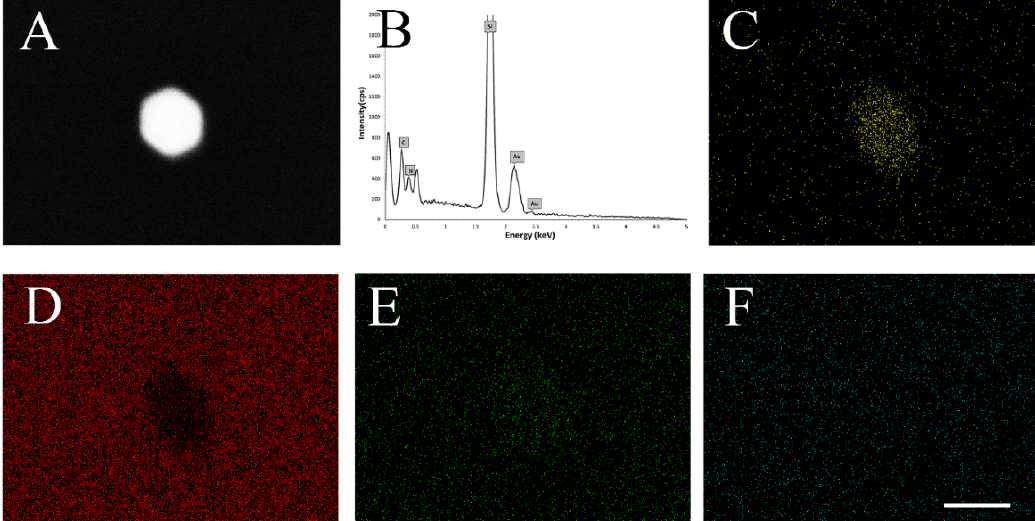
Figure 7. EDX analysis of substrate immobilized with AuNP: ( A ) SEM image of AuNP; ( B ) EDX spectrum of a point of the particle, showing peaks of gold, silicon, carbon and nitrogen; ( C ) EDX map of distribution and relative intensity of gold in scanned area; ( D ) EDX map of distribution and relative intensity of silicon in scanned area; ( E ) EDX map of distribution and relative intensity of carbon in scanned area; ( F ) EDX map of distribution and relative intensity of element nitrogen in scanned area. Scale bar stands for 50 nm.